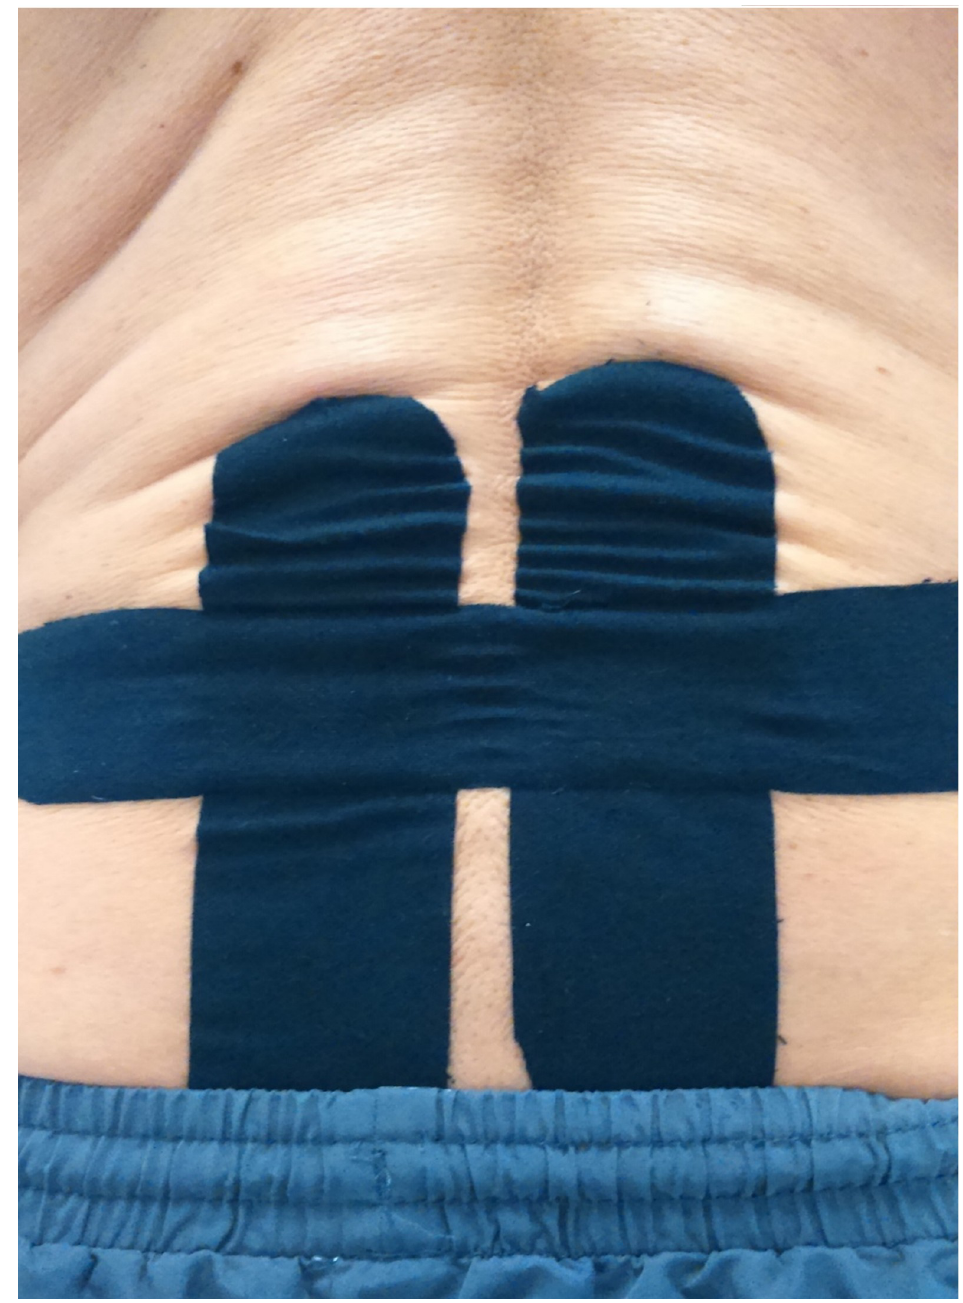
Fig 1. Figure showing visible convolutions of skin upon kinesiology